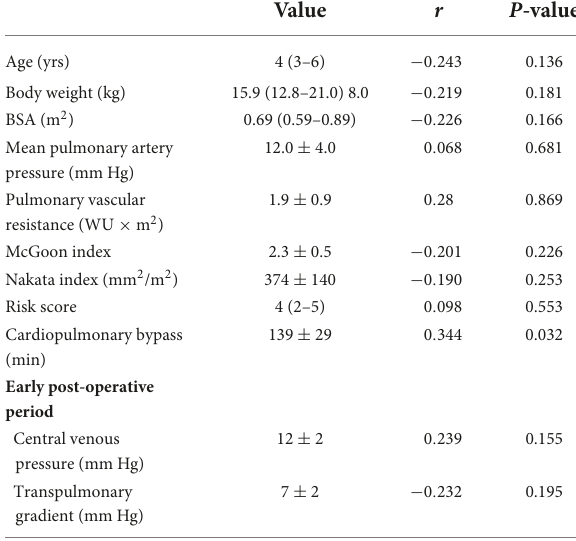
TABLE 3 Correlations between clinical and hemodynamic data at total cavopulmonary connection (TCPC) and procollagen III amino-terminal peptide (PIIINP) at